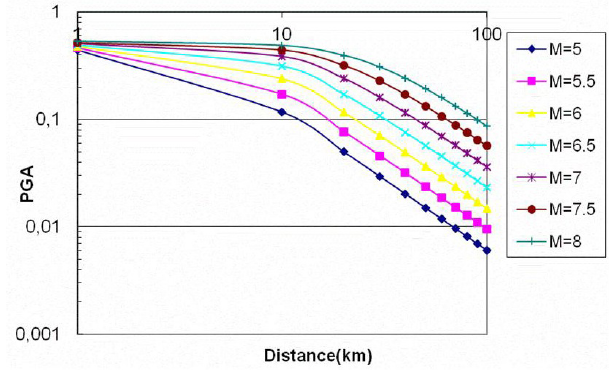
Fig. 7. The acceleration-distance relationship which is given various magnitude values according to Boore et al. (1997).